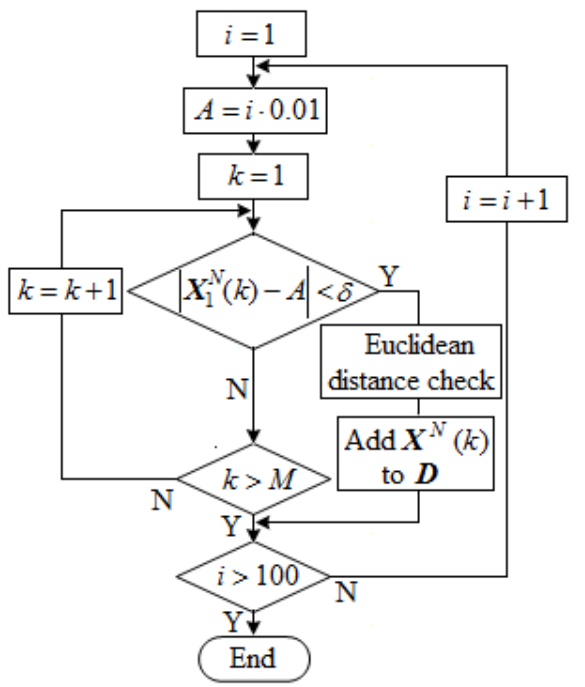
Figure 5. Construction of memory matrix D for variable x